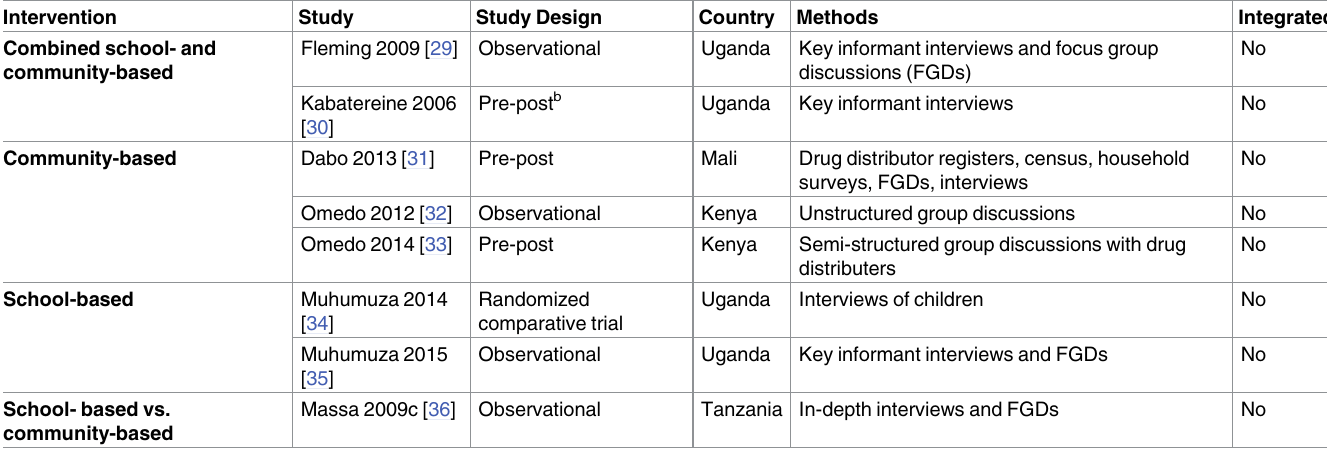
Table 2. Studies describing qualitative factors influencing coverage.